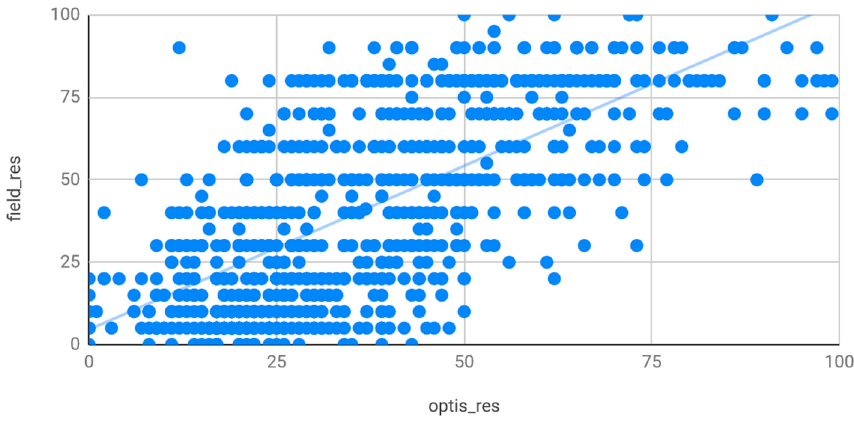
Figure 5. OpTIS and field residue cover observations have an R 2 of 0.467, p <